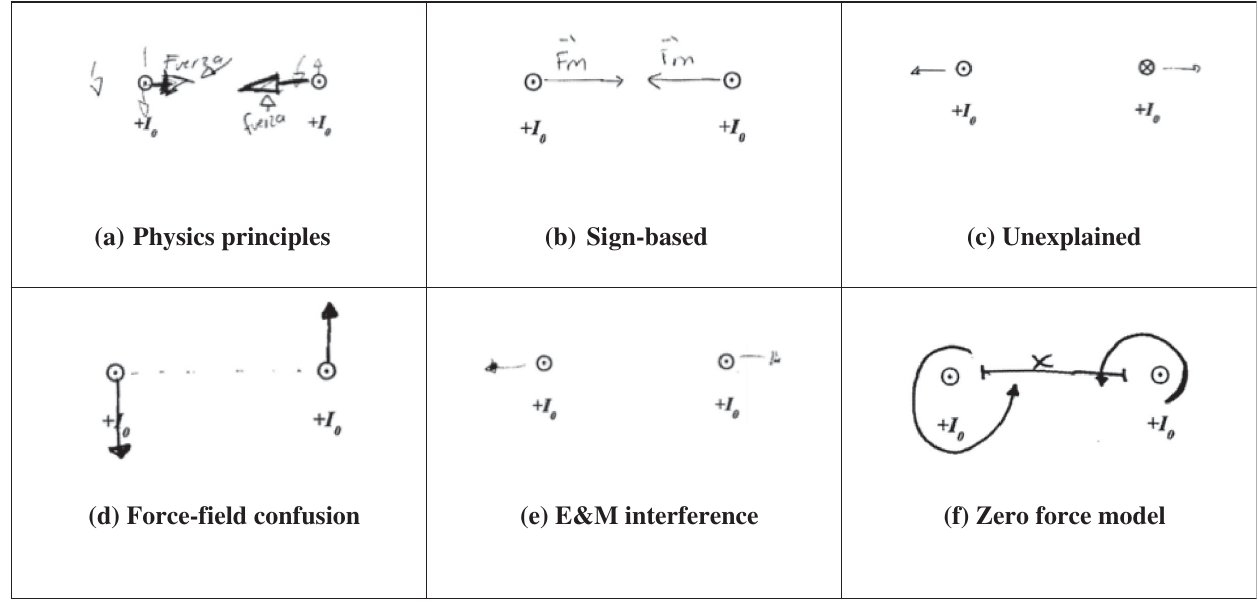
FIG. 8. Diagram examples given for each category in the magnetism version of the test. Examples a, b, d, e, and f were taken from item 1, and example c was taken from